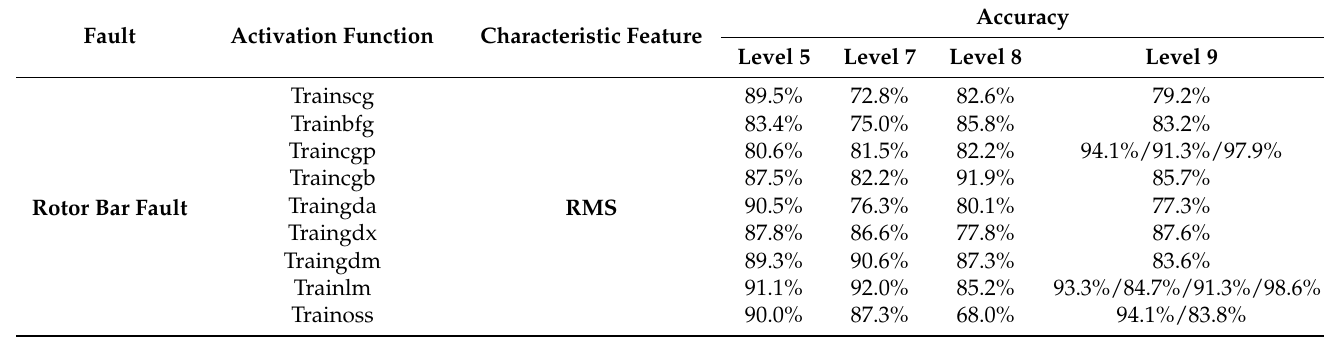
Table 4. Rotor Bar Fault with RMS Feature Accuracies under different Activation functions.